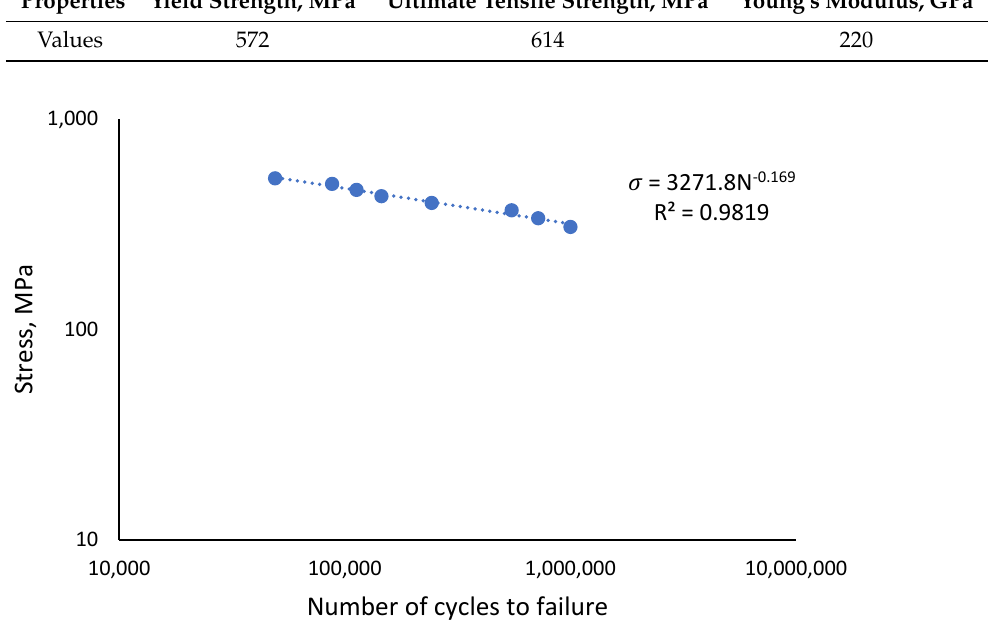
Figure 8. Fatigue behaviour of API steel X65. Table 4. Characterisation of magnetic flux leakage behaviour during uniaxial fatigue testing.